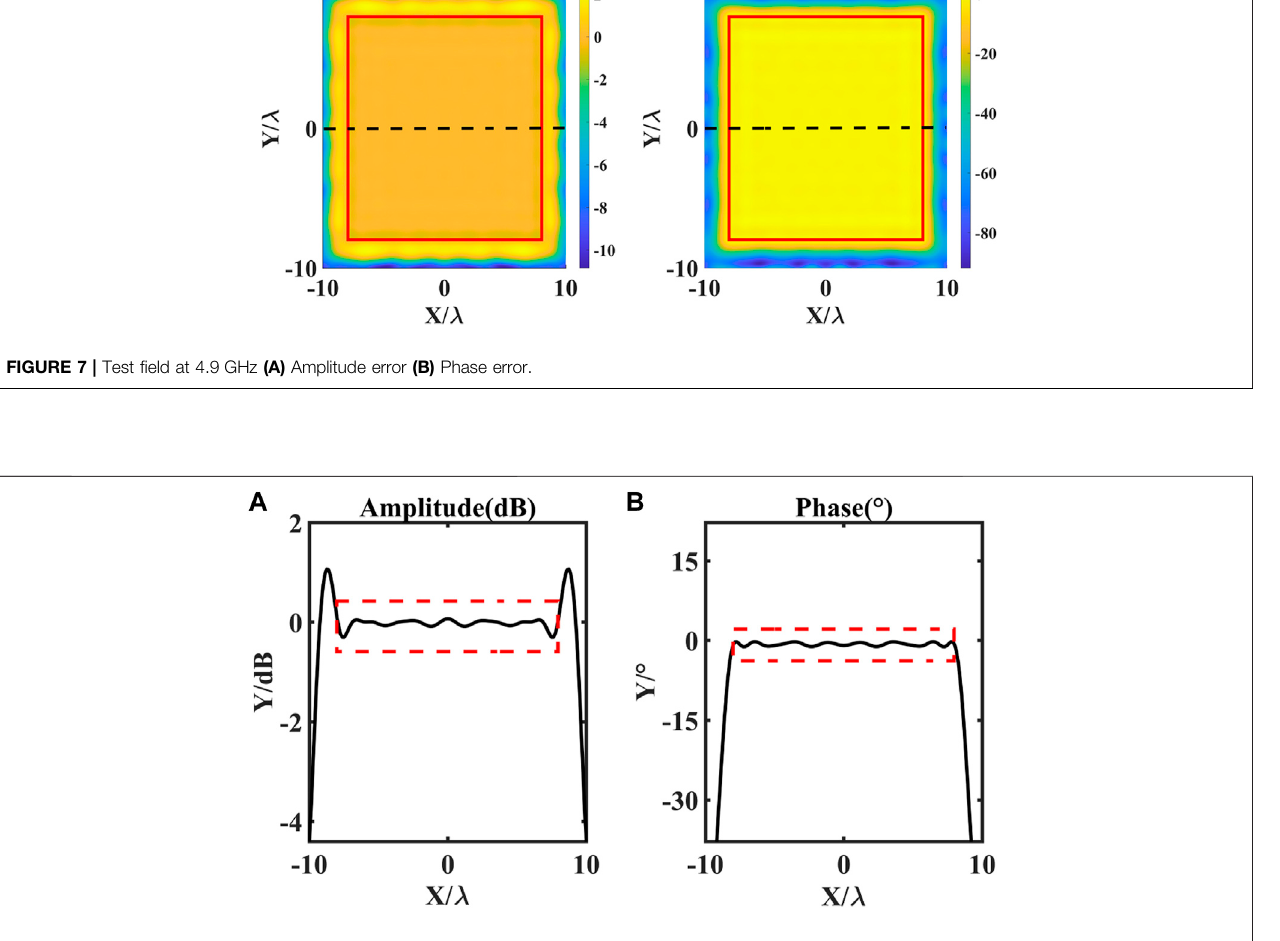
FIGURE 8 | Cross-sectional (A) Amplitude error (B) Phase